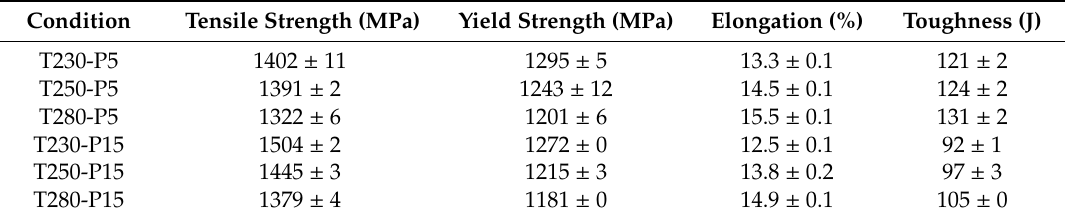
Table 1. Mechanical properties of di ff erent rail-head positions with di ff erent